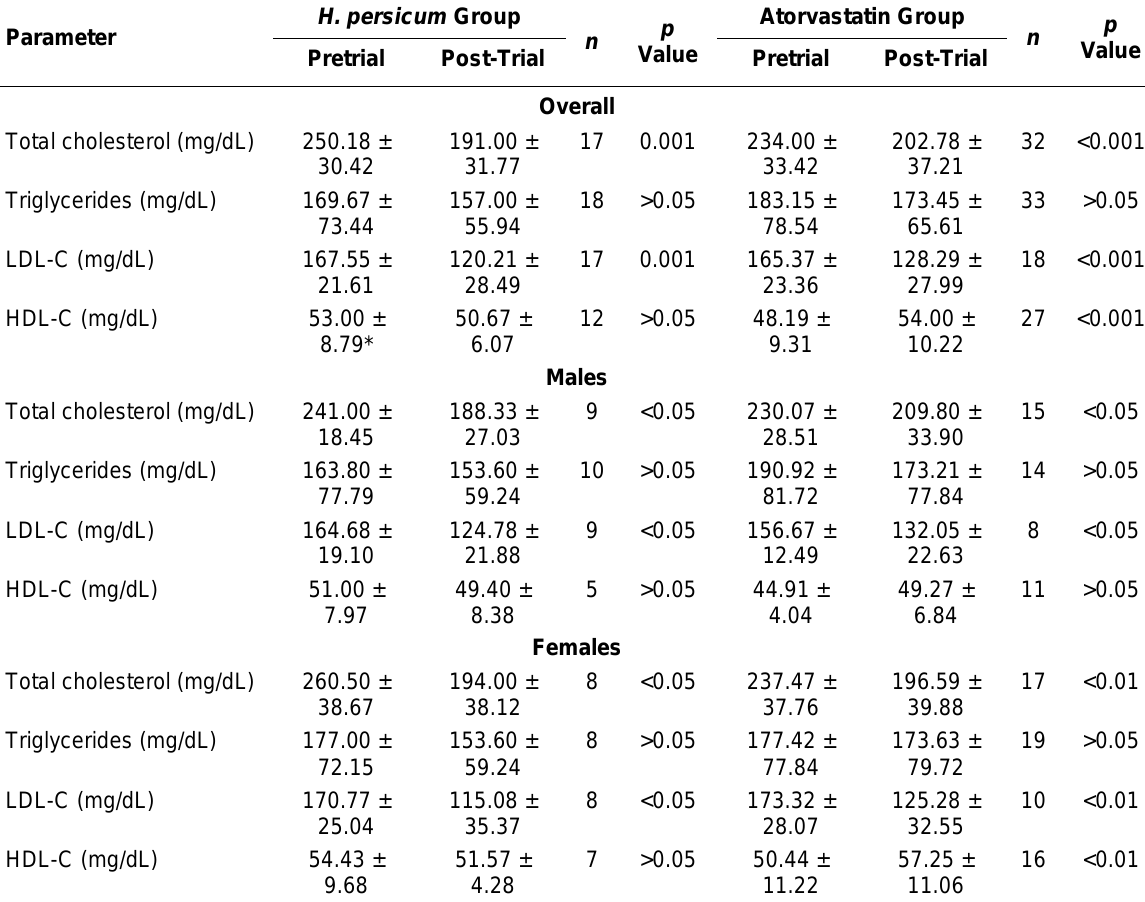
LDL-C: low-density lipoprotein cholesterol; HDL-C: high-density lipoprotein cholesterol. *Borderline significant difference between baseline values ( p = 0.051).